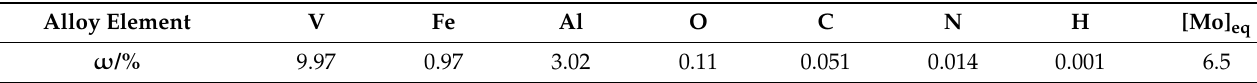
Table 1. Composition of Ti–10V–1Fe–3Al titanium alloy.